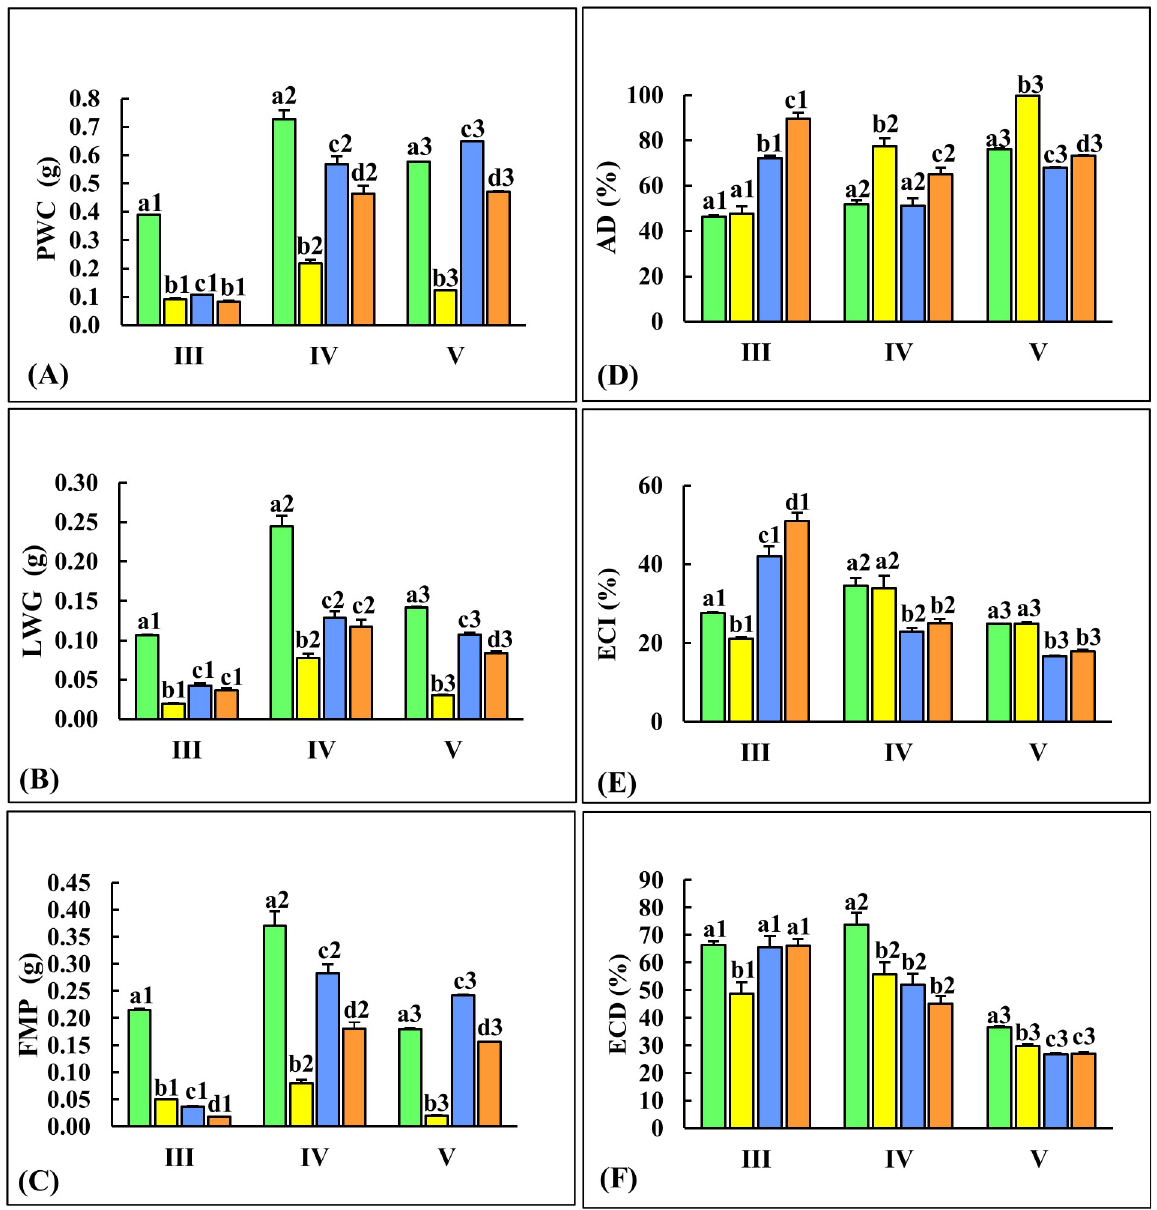
Fig 1. Type of host plant encountered in diet switching experiments influence estimates of nutritional indices in third (III), fourth (IV) and fifth (V) instars from no-choice fixed time, feeding assays. Larvae (n = 27) were reared on CF-CF (green bars), CF-GN (yellow bars), GN-CF (blue bars) and GN-GN (orange bars) diets. Panels shows (A) plant weight consumed (PWC), (B) larval weight gained (LWG), (C) fecal matter produced (FMP), (D) approximate digestibility (AD); (E) efficiency of conversion of ingested food (ECI); and (F) efficiency of conversion of digested food (ECD). Bars shows mean ± SE. Significant differences at p � 0.05 (Tukey’s HSD test) are depicted by different alphabets.